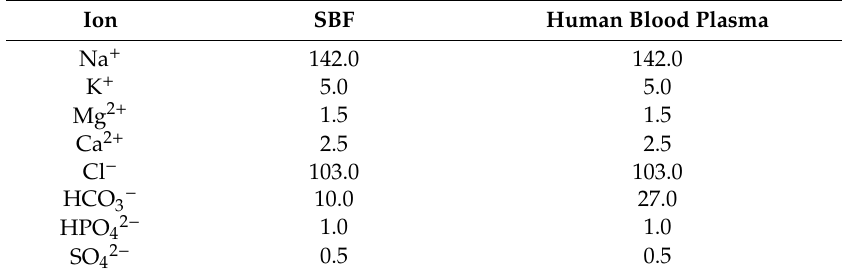
Table 2. Ion concentration (mM) in human blood plasma and simulated body fluid